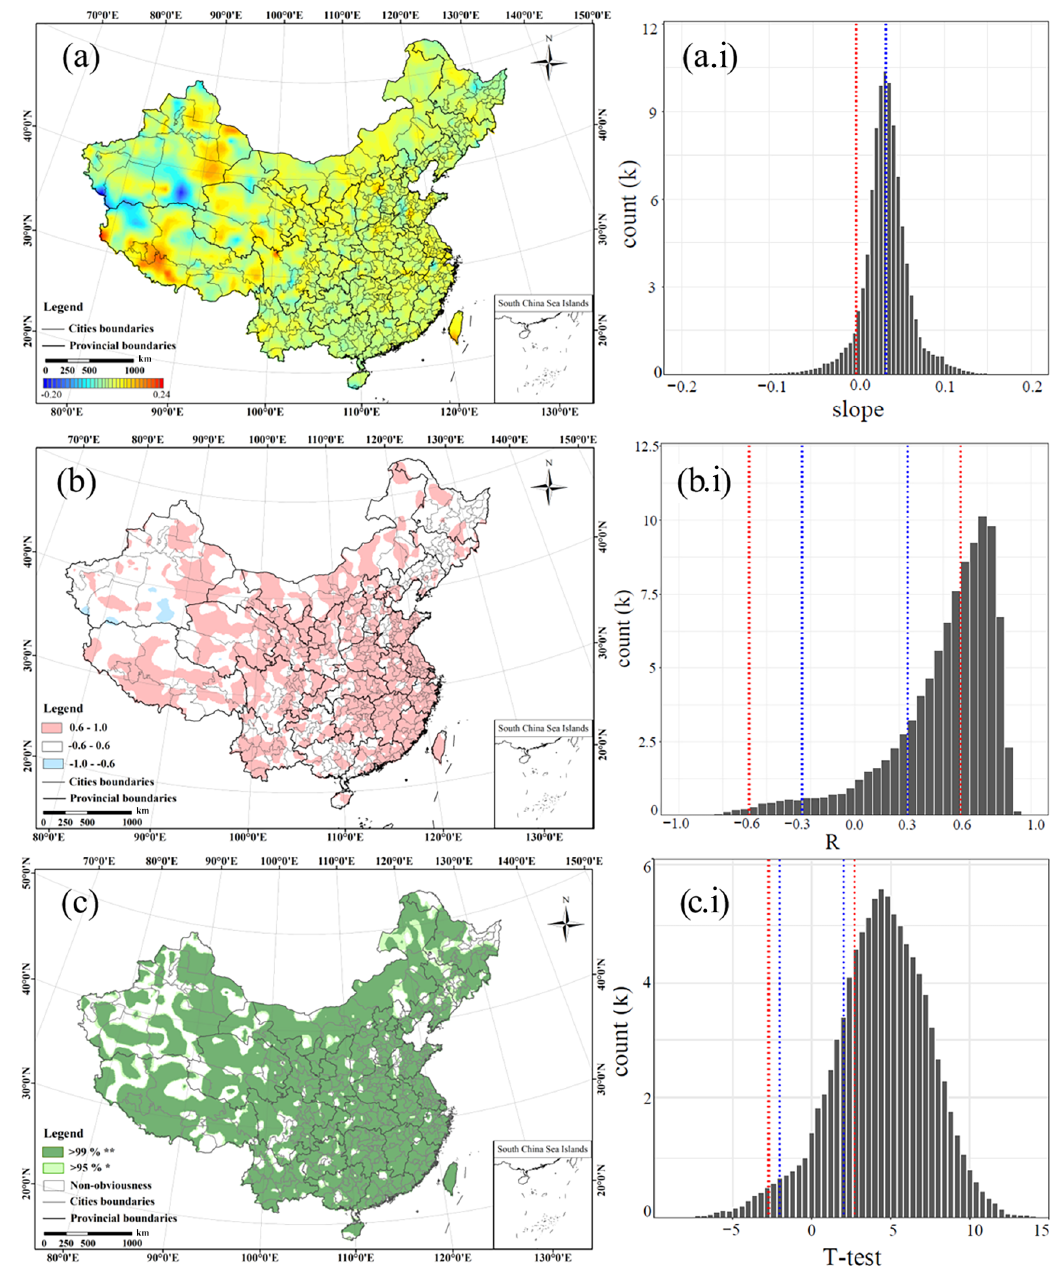
Figure 14. Multi-year climate change trends in T avg . Panel (a) K , as calculated by Eq. (7); (b) R between temperature change and time series development, calculated by Eq. (8); (c) T test ( R ), calculated by Eq. (9). Panels (a.i) , (b.i) , and (c.i) represent the distribution of pixel values in the corresponding (a) , (b) , and (c) spatial